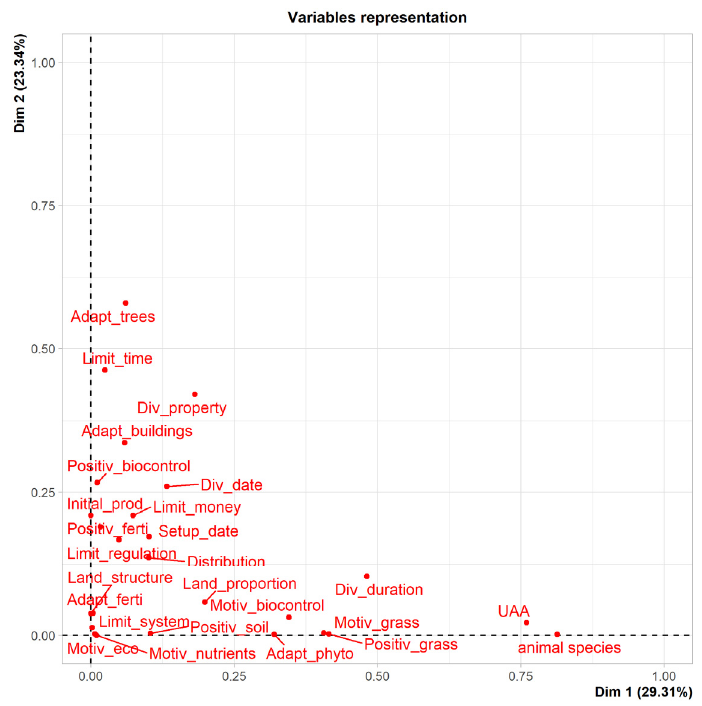
Figure A2. Variable contribution to the first two axes.